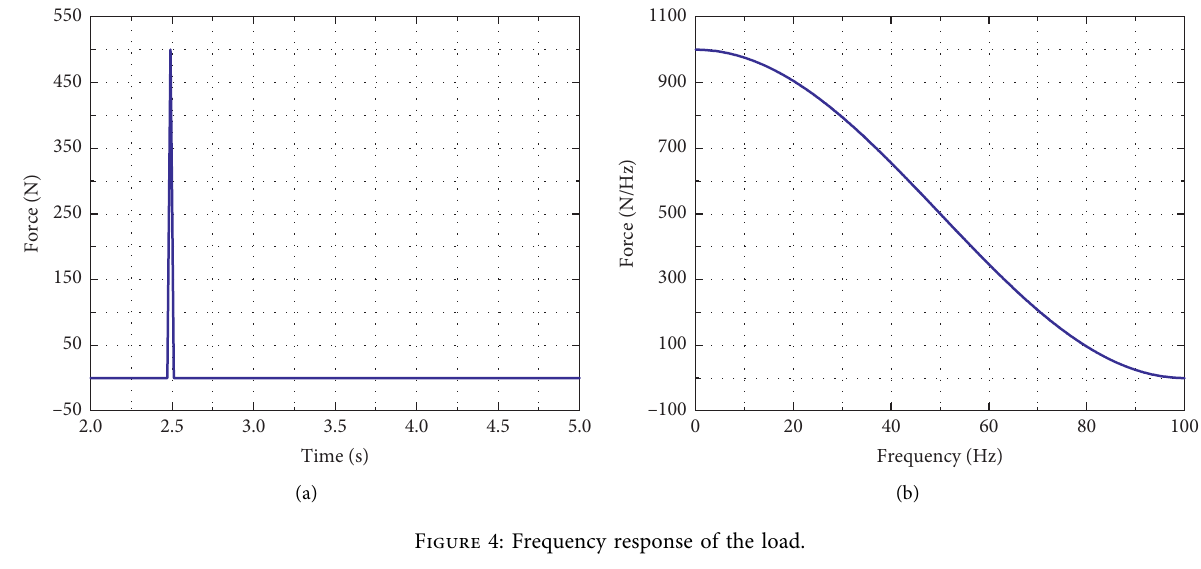
Figure 4: Frequency response of the load.